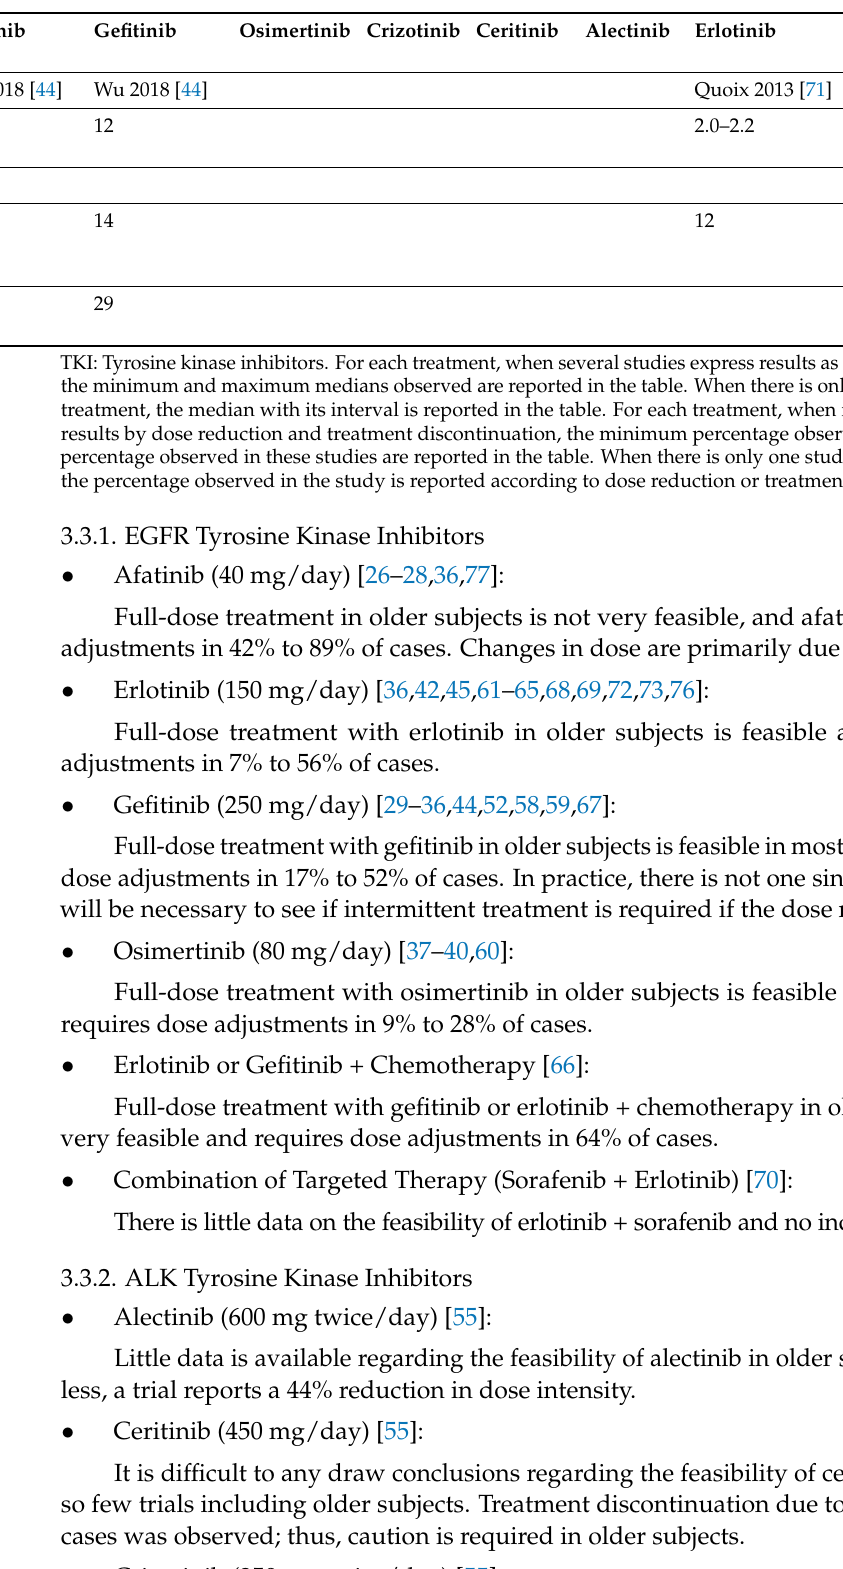
Table 7. Targeted therapy feasibility results in older patients in randomized